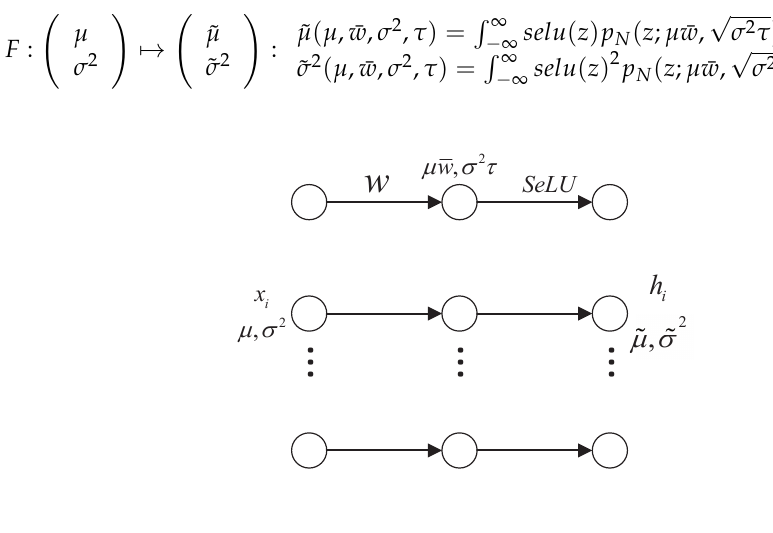
Figure 3. The block diagram of